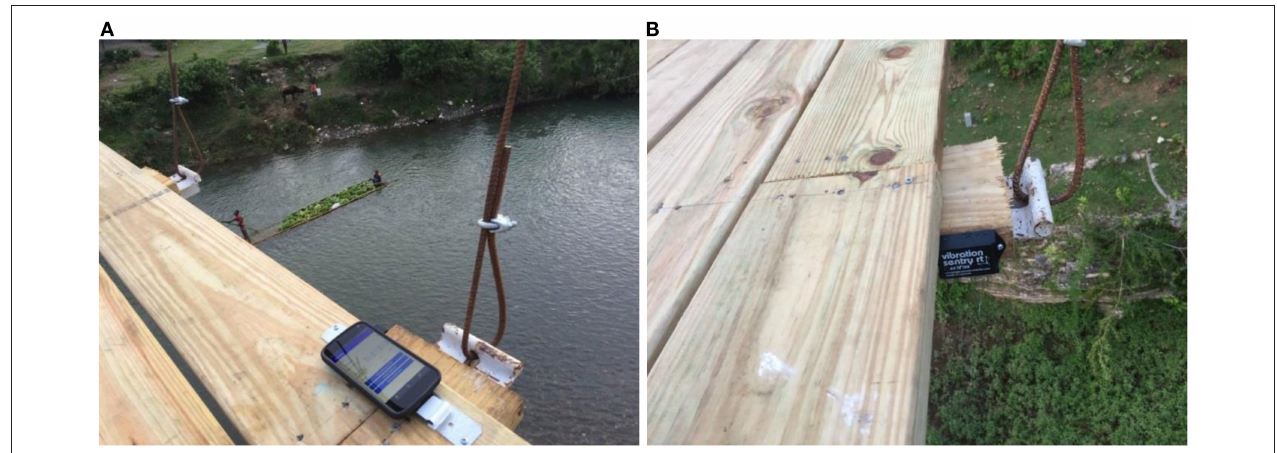
FIGURE 3 | Examples of sensor installation to footbridge: (A) Nexus 4 smartphone; (B) Vibration